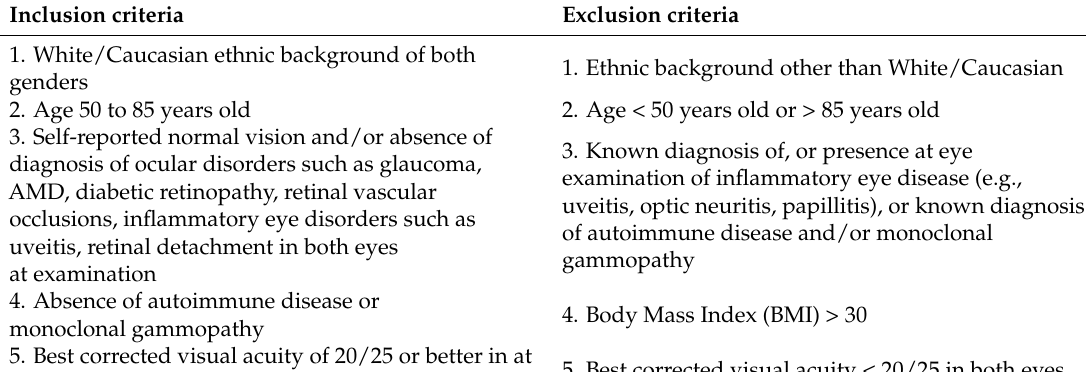
Table 1. Inclusion and exclusion criteria for participation in